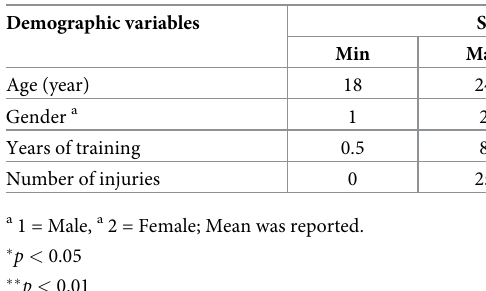
Table 1. Demographic information of